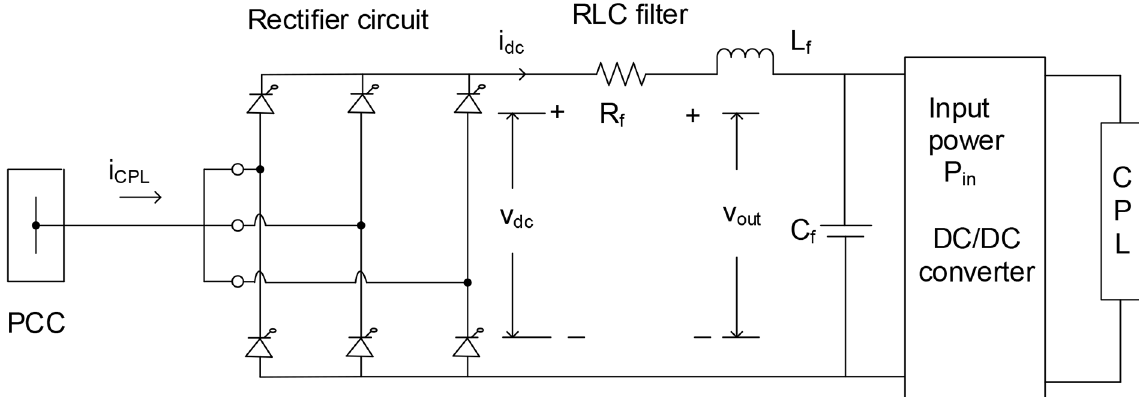
Fig 2. 3-phase diode rectifier and RLC filter in an AC microgrid [12, 13].